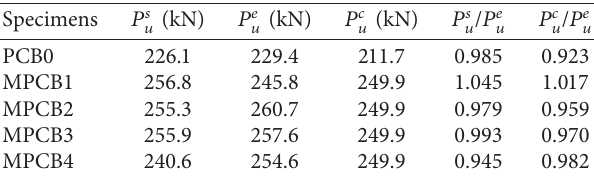
Table 2: Comparison of simulated value, theoretical value, and experimental